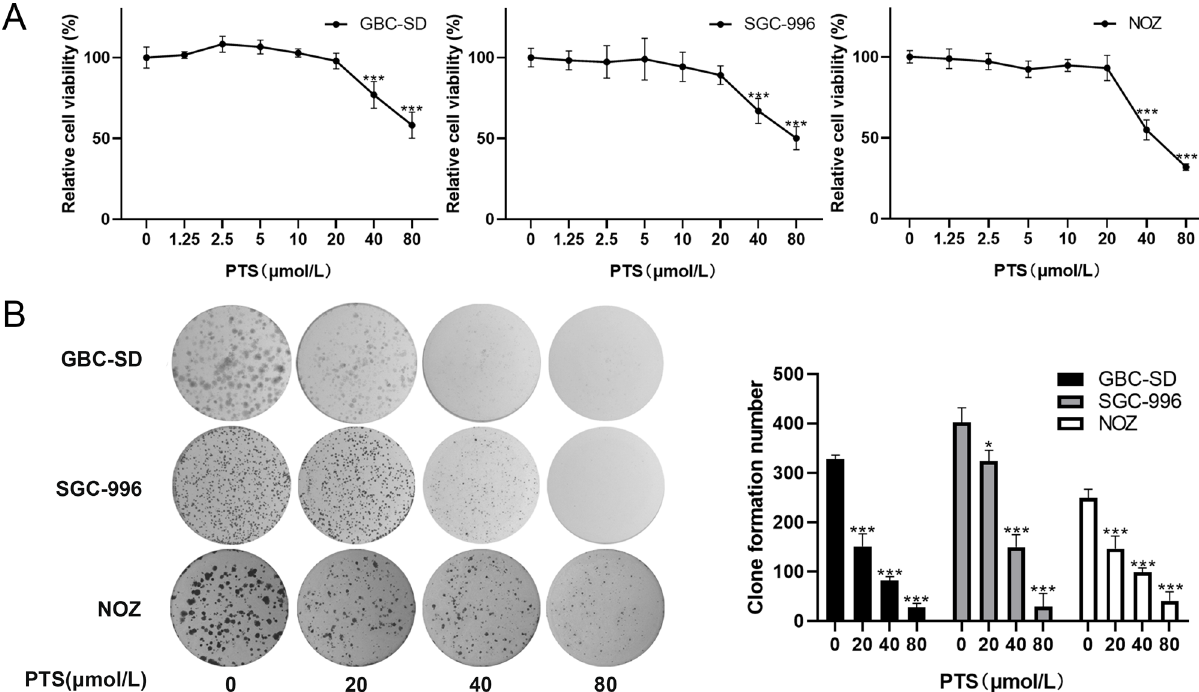
Figure 1. PTS decreased the viability of human GBC cells. ( A ) The CCK8 assay showed that PTS induced a dose-dependent cytotoxicity in GBC-SD, SGC-996 and NOZ cells. ( B ) Colony formation assays